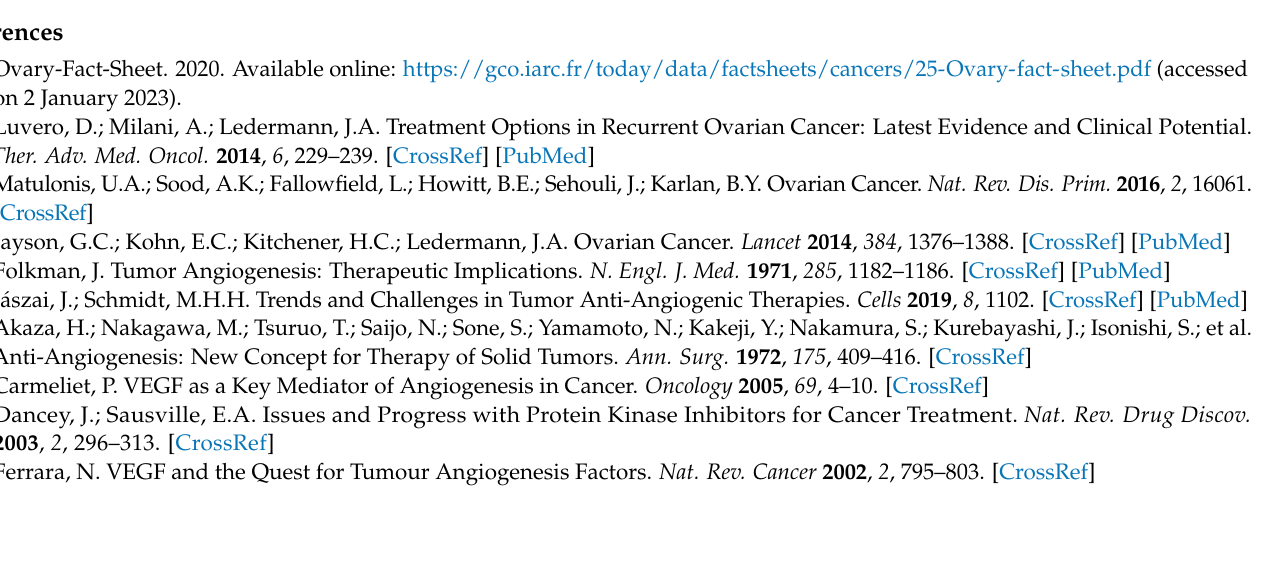
Figure S1: Hypertension; Figure S2: Hemorrhagic events; Figure S3: Thrombosis and embolism; Figure S4: Arterial thromboembolism; Figure S5: Venous thromboembolism; Figure S6: Protein- uria; Figure S7: Reversible posterior leukoencephalopathy syndrome; Figure S8: Gastrointestinal perforation; Figure S9: Infection; Figure S10: Pyrexia; Figure S11: Wound related issues; Figure S12: Ascites; Figure S13: Neutropenia; Figure S14: Anemia; Figure S15: Leucopenia; Figure S16: Throm- bocytopenia; Figure S17: Nausea; Figure S18: Vomiting; Figure S19: Anorexia; Figure S20: Di- arrhea; Figure S21: Constipation; Figure S22: Fatigue; Figure S23: Dyspnea; Figure S24: Alope- cia; Figure S25: Rash; Figure S26: Hypomagnesemia; Figure S27: Hypokalemia; Figure S28: Pain; Figure S29: Headache; Figure S30: Abdominal pain; Figure S31: Back pain; Supplementary Materials 2—PRISMA checklist; Supplementary Materials 3—Graphical representation of statistical analysis containing Figures S32–S35: Figure S32—Sensitivity analysis (OS); Figure S33—Sensitivity analysis (PFS); Figure S34—Radial plots (OS); Figure S35—Radial plots